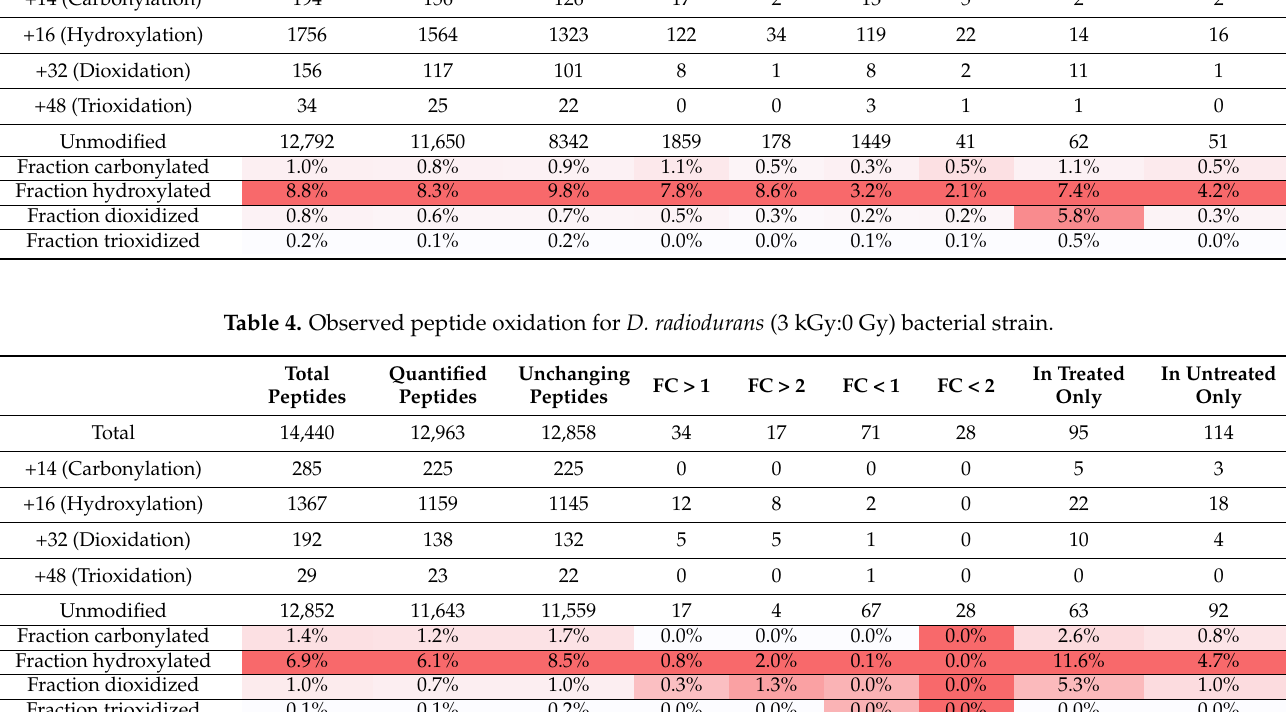
Table 3. Observed peptide oxidation for IR9-150-2 (3 kGy:0 Gy) bacterial strain. Total Quantified Peptides Peptides